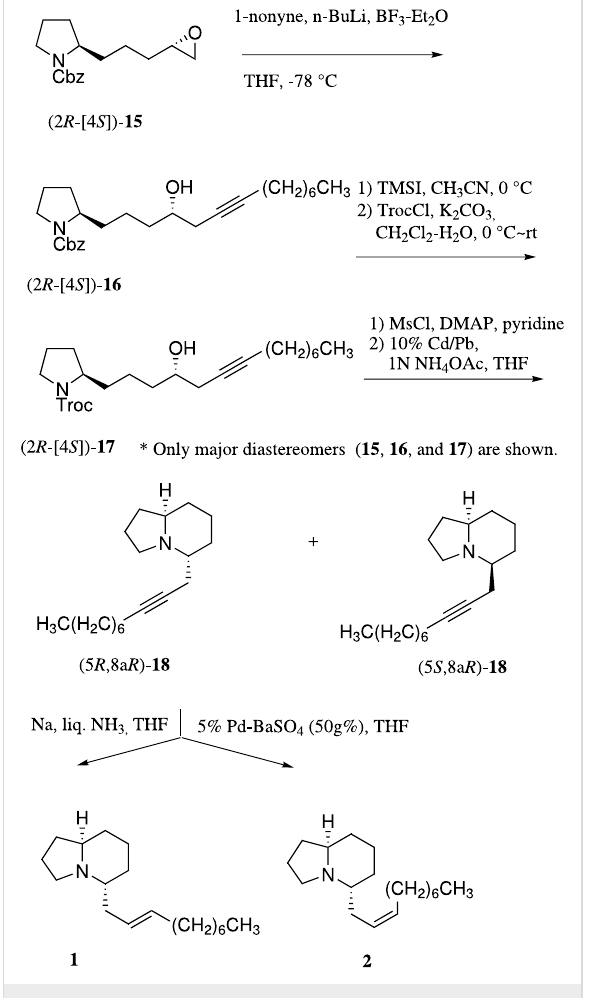
Scheme 3: Asymmetric synthesis of piclavines A1 and A2 from (2 R - [4 S ])- 15 .